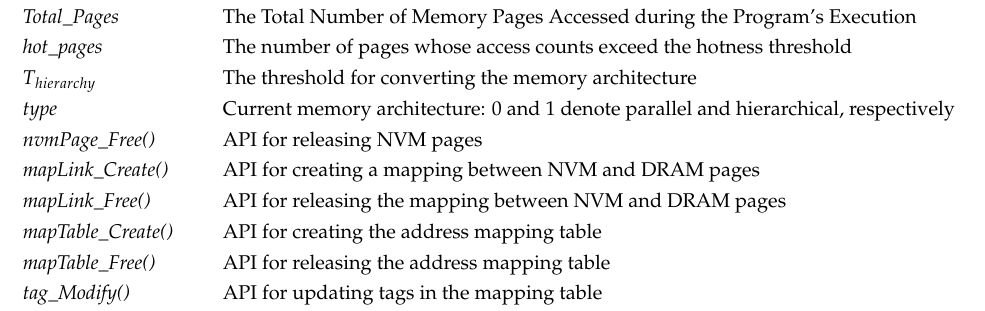
Table 1. Notations and